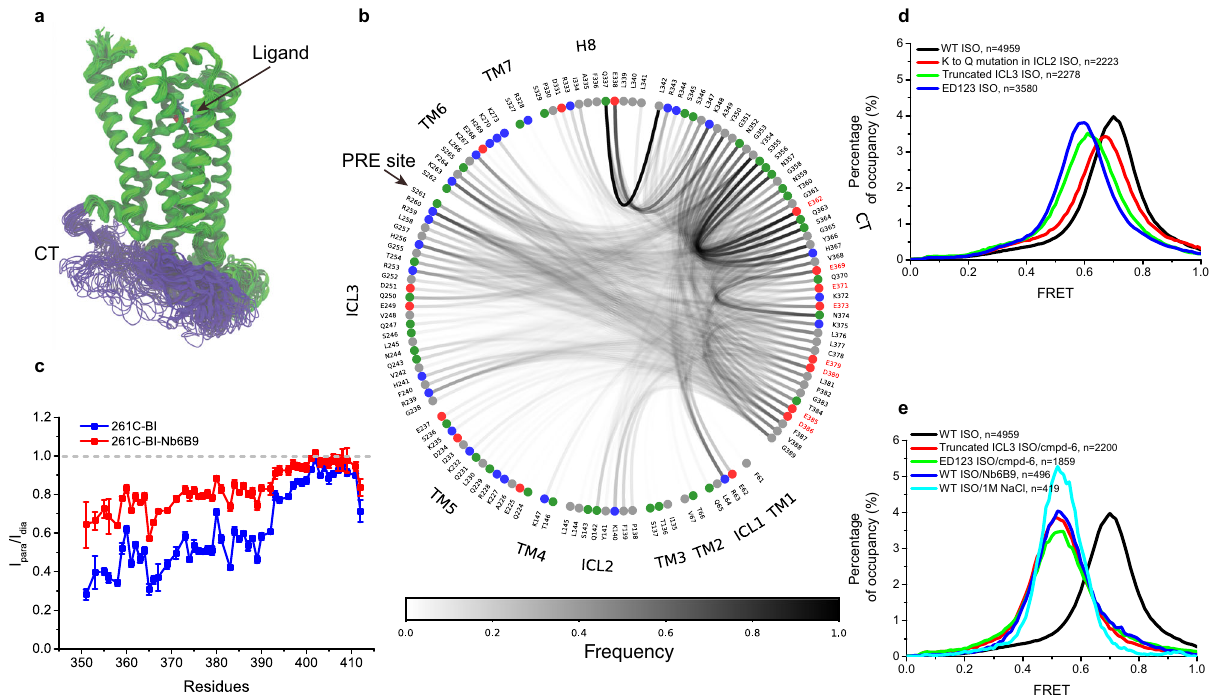
Fig. 7 | Contacts between the β 2AR-[CT] and intracellular loop regions of the the CT are shown. c The potential interaction between CT and ICL3 was measured β 2AR. a Superimposed snapshots of the β by a paramagnetic relaxation enhancement experiment (PRE). A spin probe IA- 2 AR from one representative MD tra- TEMPO was attached to residue 261C at the C-terminal end of ICL3, and the jectory(outof50).TheCTisshowninpurple, and the remainderofthe receptoris distance-dependent PRE effectwas evaluated by the intensity ratio(I para /I dia ) of 1 H, in green. The green highly mobile region belongs to the ICL3. We show here one 15 N-HSQCcross-peaksversusprimarysequenceat293K.TheerrorbarsforI para and snapshot every 2ns with a smoothing window of fi ve frames from a 200ns tra- I dia represent meanand s.e.m. of 3 sequential 8h measurements. d Mutagenesis to jectory. b Residue-residuecontactsacrosstheaggregated50MDtrajectories(10 μ s remove all the negatively charged residues in the CT (ED123), truncation of ICL3 total simulation). Red and blue dots represent negatively and positively charged region236-263(TruncatedICL3),andneutralizationofthepositivechargebyLysto residues, respectively, while green and gray ones are neutral hydrophilic and Gln mutagenesis in ICL2 (K to Q mutation in ICL2) affect the FRET distribution. neutral hydrophobic residues, respectively. The curve between two dots indicates e Conditions that show complete disruption of CT and core-domain interactions that the two respective residues are in contact distance of at least 3.5Å, with the revealed by FRET distributions of opacity of each curve representing contact frequency. The negatively charged residuesoftheCTarefurtherhighlightedinredtextlabels.Onlycontactsinvolving